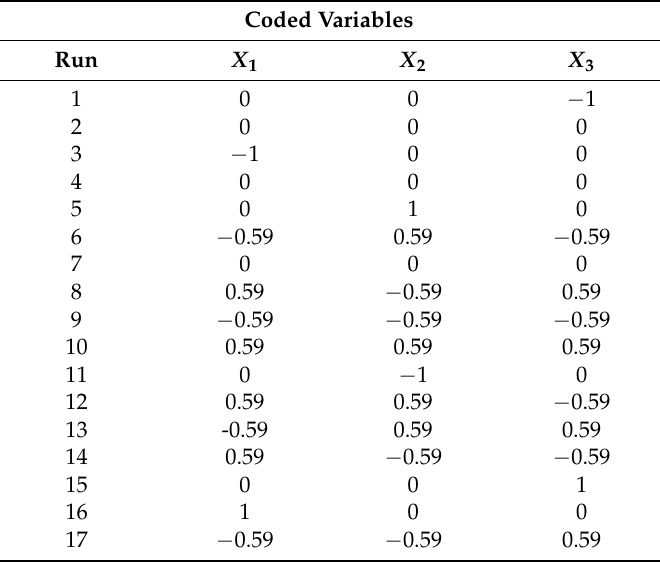
Central composite circumscribed (Min and Max = Star Points) design with three independent variables.